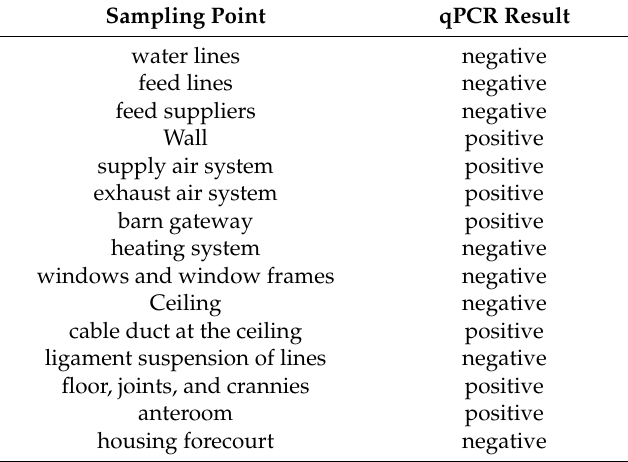
Table 2. Sampling regime and qPCR-results: Salmonella presence in the barn after cleaning and disinfection was confirmed with the following sampling plan before the start of the first rearing period. All qPCR positive samples were confirmed as S . Java by classical